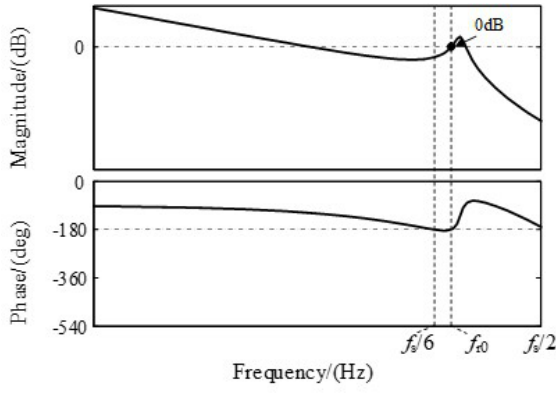
Fig. 7. Bode Diagram of T CCFAD0 0 ( s )